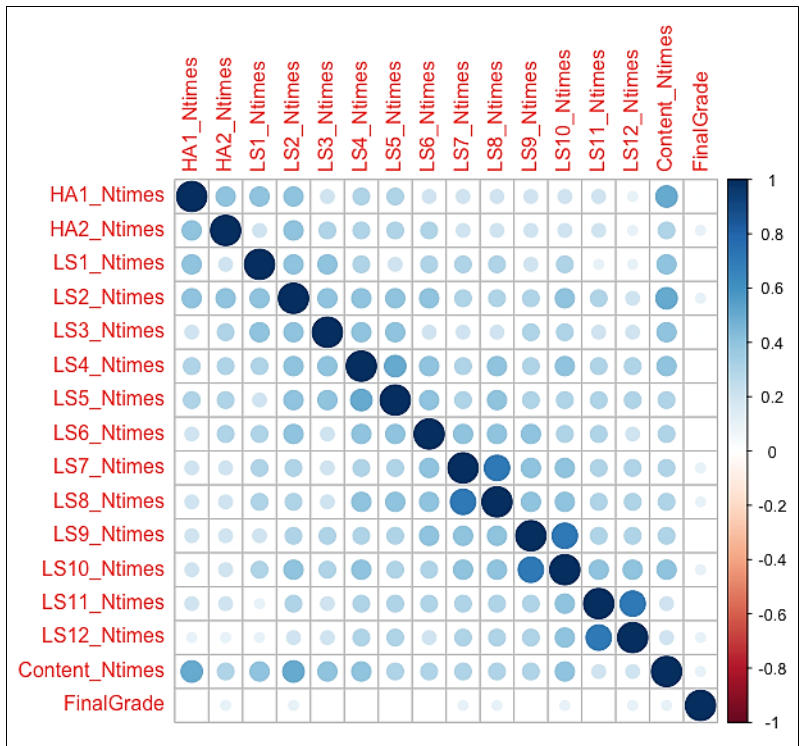
Figure 6. Correlation plot for homework & lab assignments and final